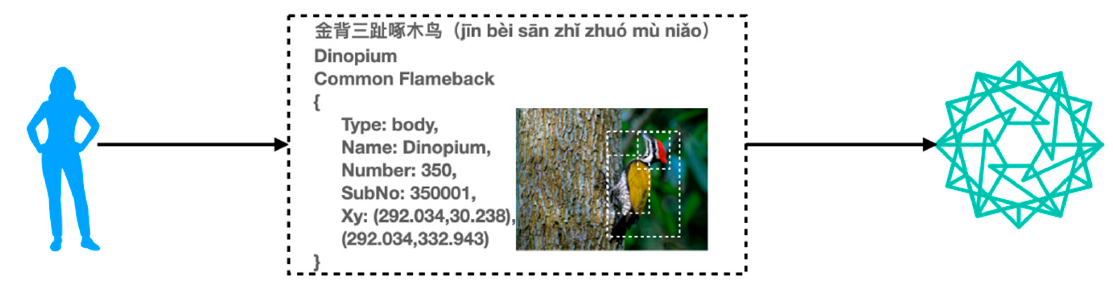
Figure 8. Blockchain-based data storage model for birds.